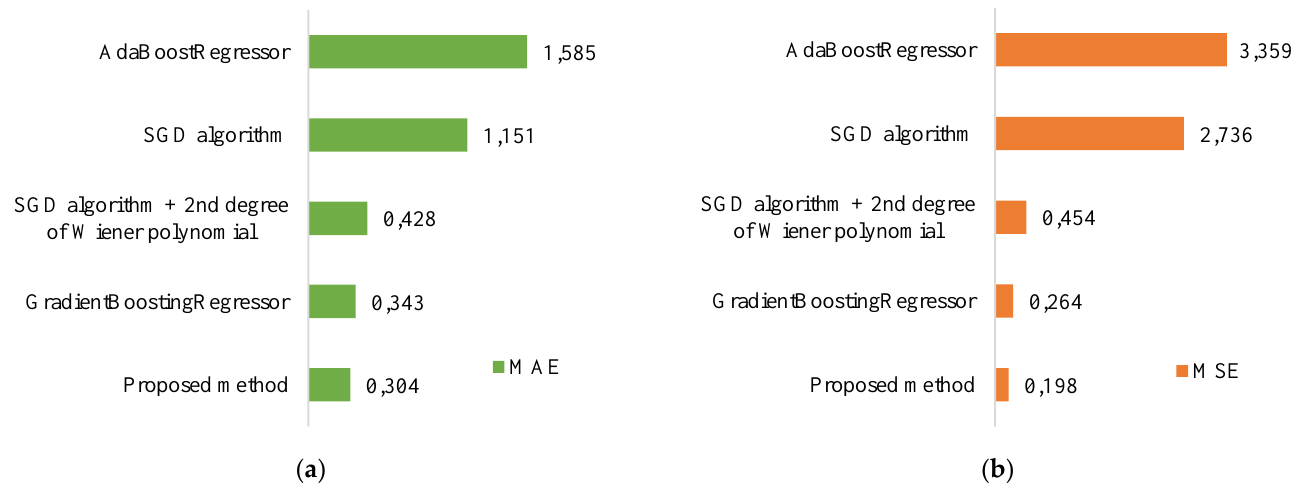
Figure 7. Prediction accuracy of all investigated methods using: ( a ) MAE; ( b ) MSE.